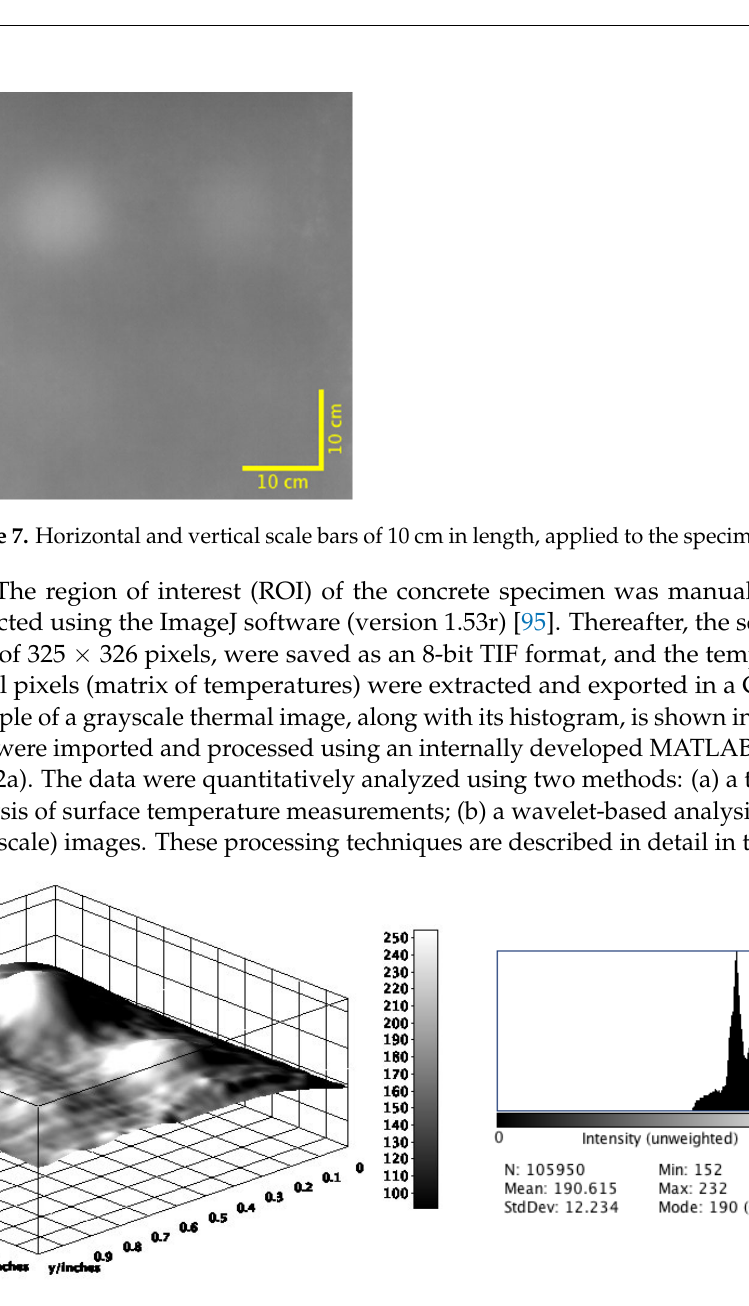
Figure 8. Three-dimensional surface plot of the grayscale thermal image (8-bit) of the concrete specimen, monitored with an infrared camera after continuous heating for 2 h. The color bar on the right side of the surface plot depicts the grayscale level.